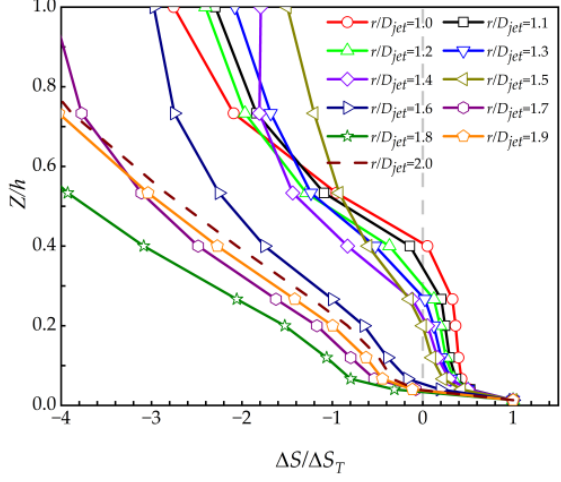
Figure 14. The dimensionless speedup ratio at the vertical height of the hilltop. As shown in Figure 14, the speedup ratio at the hilltop can be obtained from Equation (9), so the speedup ratio at the hilltop is dimensionless and used to investigate the variation of the speedup ratio with vertical height. At a vertical height of 0.45 h and a radial position of 1.0 D jet , the hill’s speedup ratio displays a deceleration effect, and this trend remains consistent until then. In order to ensure the effectiveness and universal applicability of the model, a working condition was selected where the speedup ratio changes gradually with vertical height. Specifically, the speedup ratio of a hill at a radial position of 1.0 D jet was selected as the basis for model development. The expressions for the variation of the speedup ratio of the hill with height are shown below, as shown in Figure 15. That is, when the vertical height is below 0.2 h , the predicted speedup ratio values of the model are all greater than those of numerical simulation. However, a deceleration effect occurs when the hill height exceeds 0.5 h , which means the speedup effect is not considered at this point.